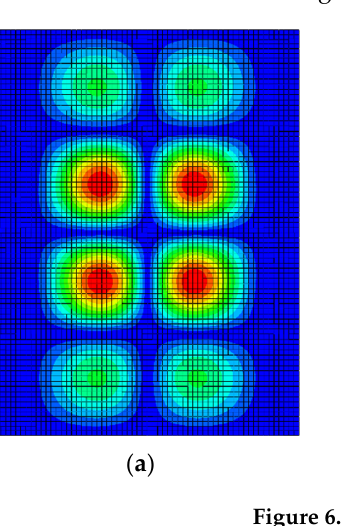
Figure 6. Initial imperfections with different half-waves along plate length and one half-wave along plate width between longitudinal stiffeners ( a ) 2 half-waves, ( b ) 3 half-waves, ( c ) 4 half-waves.